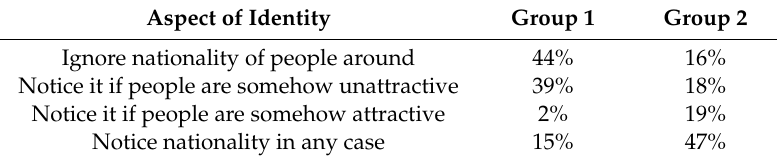
Table 3. Actualization of ethnic factor in the course of interaction (n1 = 100, n2 =